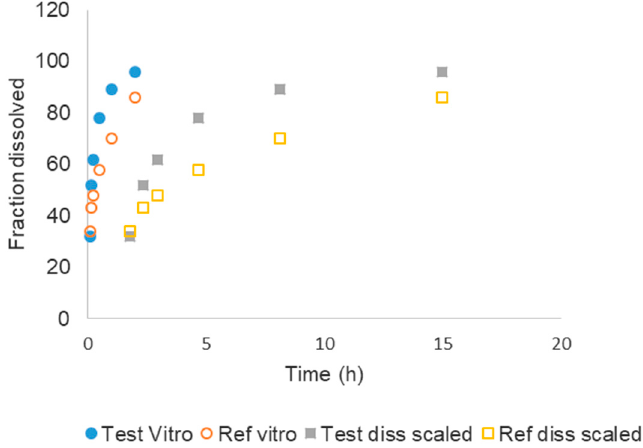
longer univocal. univocal.